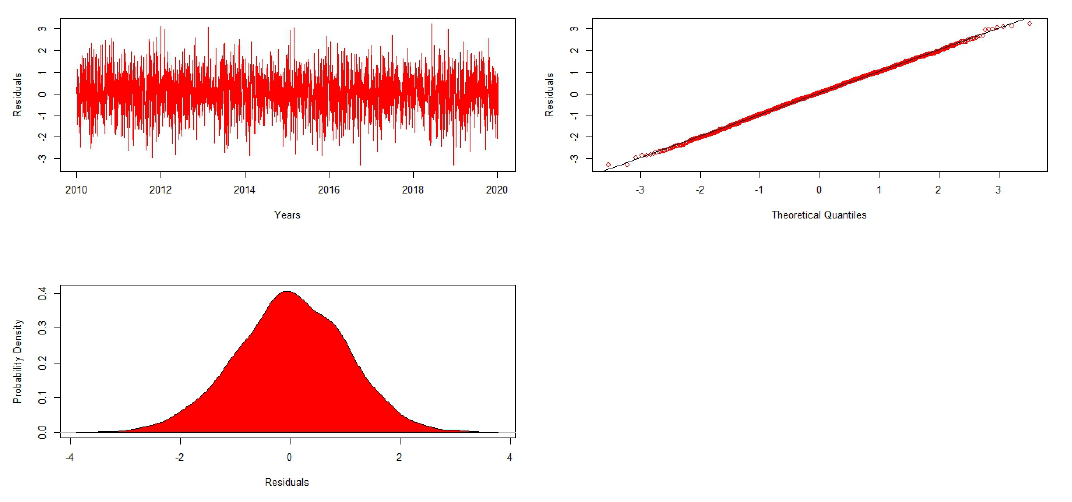
Figure 2. Residuals; probability density and the Q-Q plot.